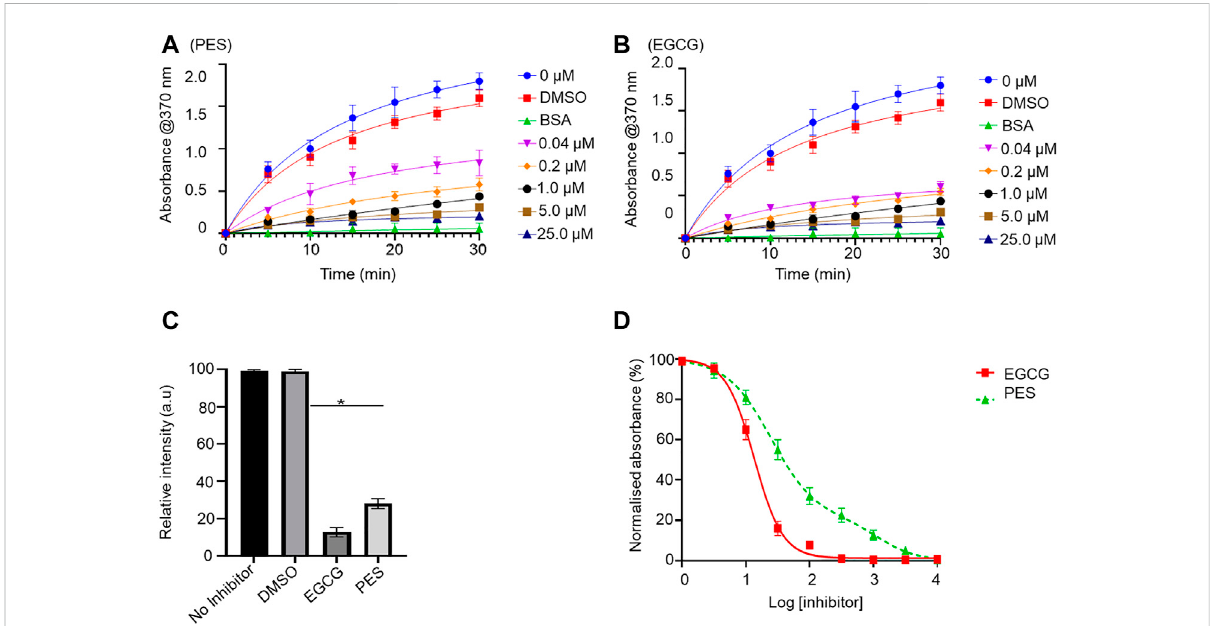
FIGURE 7 PESsuppressesPfHop-PfHsp70-1association.PfHsp70-1wasimmobilizedontotheELISAplateandPfHop(analyte)wassuspendedalongwith varying concentrations of PES. DMSO and BSA were used as controls. Representative binding curves obtained for the association of PfHsp70-1 and PfHop in the presence of (A) PES and EGCG (B) are shown. Bar graphs showing the comparative effects of the inhibitors on the interaction of PfHsp70-1andPfHopareprovided (C) .Theresultant dose-responsecurvesforbothPESandEGCGareshown (D) .Theerrorbarsrepresentthe standard deviations obtained from three independent assays conducted independently. Student t-test statistical signi fi cance of differences of inhibitor compared to the vehicle control, DMSO, are indicated by asterisks positioned above the bar graphs ( p <